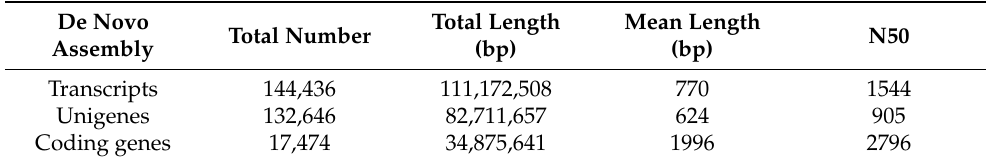
Table 2. Assembly statistics from the female abdomen (FAb), female antennae (FAn), and male antennae (MAn) of Anastatus japonicus